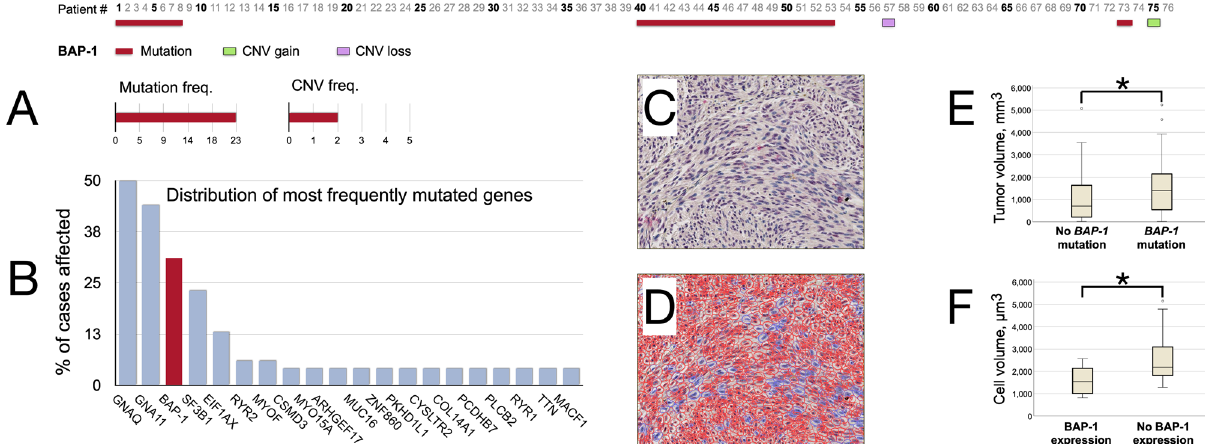
Figure 1. Results of whole exome sequencing and digital image analysis of BAP1 immunohistochemistry. ( A ) Distribution of BAP1 mutations and copy number variations (CNV) across the 76 included patients from The Cancer Genome Atlas (TCGA, https:// portal. gdc. cancer. gov/ proje cts/ TCGA- UVM). Twenty-two patients had a BAP1 mutation, 1 patient had a BAP1 CNV gain, and 1 patient had a BAP1 CNV loss. ( B ) Distribution of the most frequently mutated genes as proportion of the cohort. ( C ) BAP1 immunohistochemistry. In this example, most tumor nuclei have retained their BAP1 expression (lilac) whereas some have lost their expression (blue). ( D ) Excerpt from digital image analysis of the same tumor section shown in B. Tumor cells with retained and lost BAP1 expression are indicated in red and blue, respectively. ( E ) Tumors with a BAP1 mutation had significantly larger mean volume than those with wild-type BAP1 (2109 vs. 1552 mm 3 , p = 0.025). ( F ) tumor cells with loss of BAP1 expression had significantly larger mean volume (2657 μm 3 , SD 1283) than those with